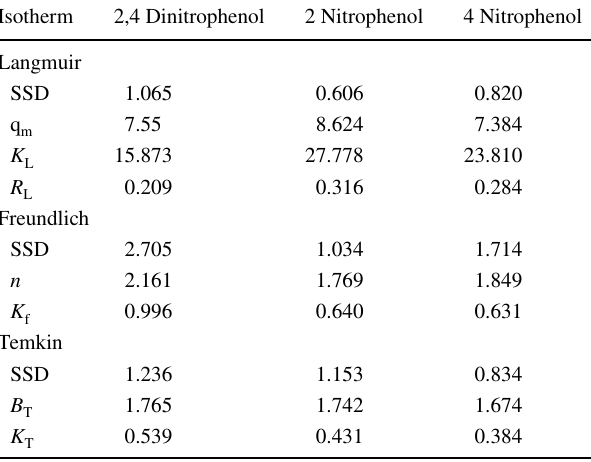
Table 3 Nonlinear adsorption constants for the applied two-parame- ter adsorption